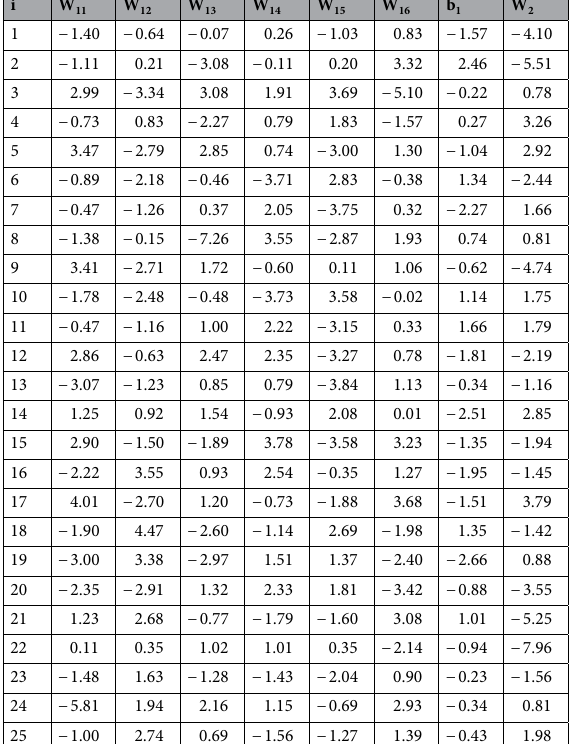
Table 6. Weights and biases (b2 =